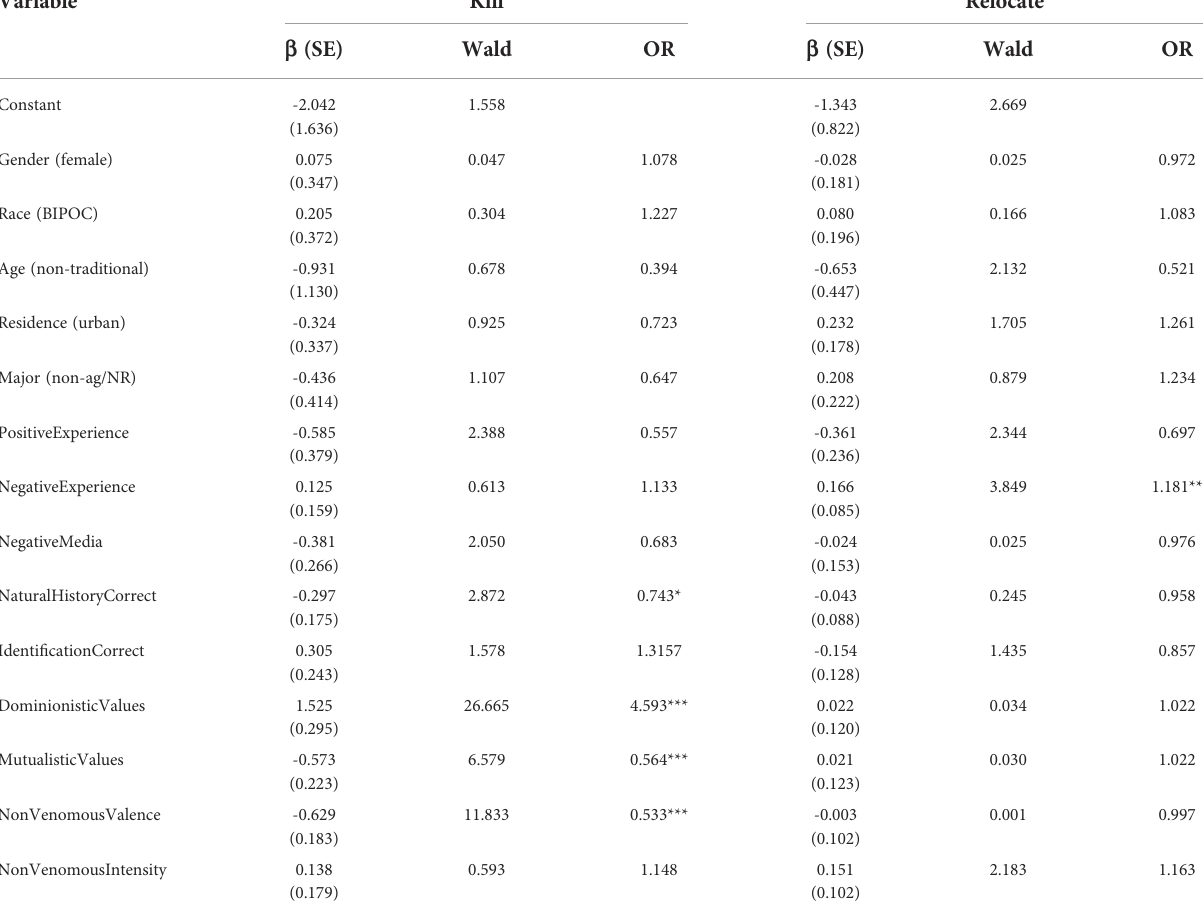
TABLE 2 Parameter estimation from the multinomial logistic regression model predicting tolerance of non-venomous snakes (measured as reaction to seeing a non-venomous snake “ right outside of your residence ” ) among college students in North Carolina (n = 743).